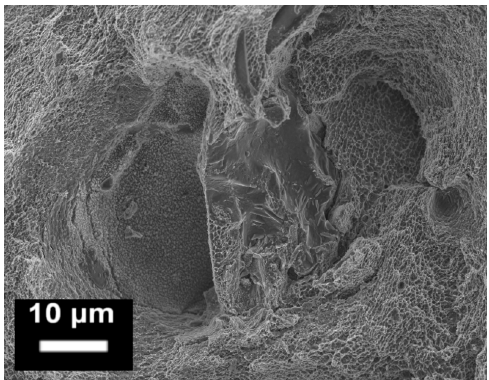
Figure 15. Example of oxide layers on the fracture surface of an SLM AlSi10Mg tensile specimen observed by FESEM. The central smooth area represents a fragile rupture region, and is different from the surrounding fine dimple regions, which are characterized by ductile fractures (from the authors’ own unpublished work).